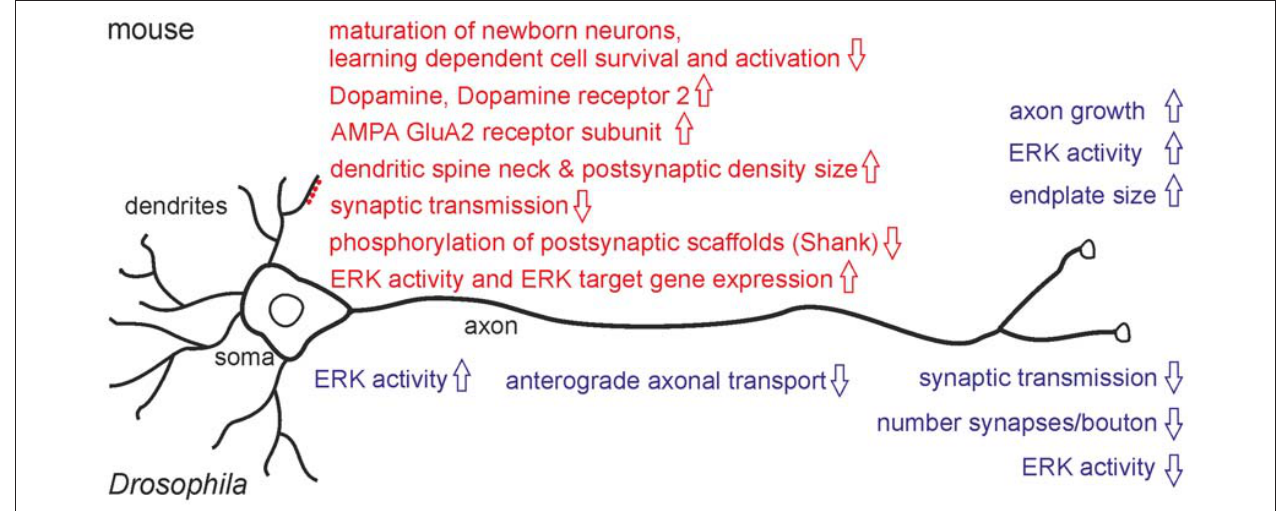
FIGURE 2 | Major neuronal phenotypes observed in RSK2 knock-out mice (upper part) and D-RSK mutants (lower part). Motoneuron phenotypes are indicated in blue, effects on CNS neurons with their dendritic spines are highlighted in red.